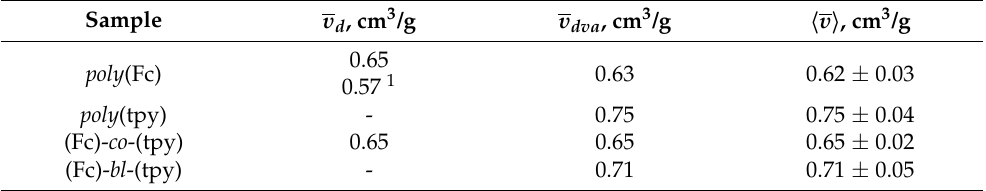
Table 2. The partial specific volume values, obtained with densitometry ( υ d ) in THF and